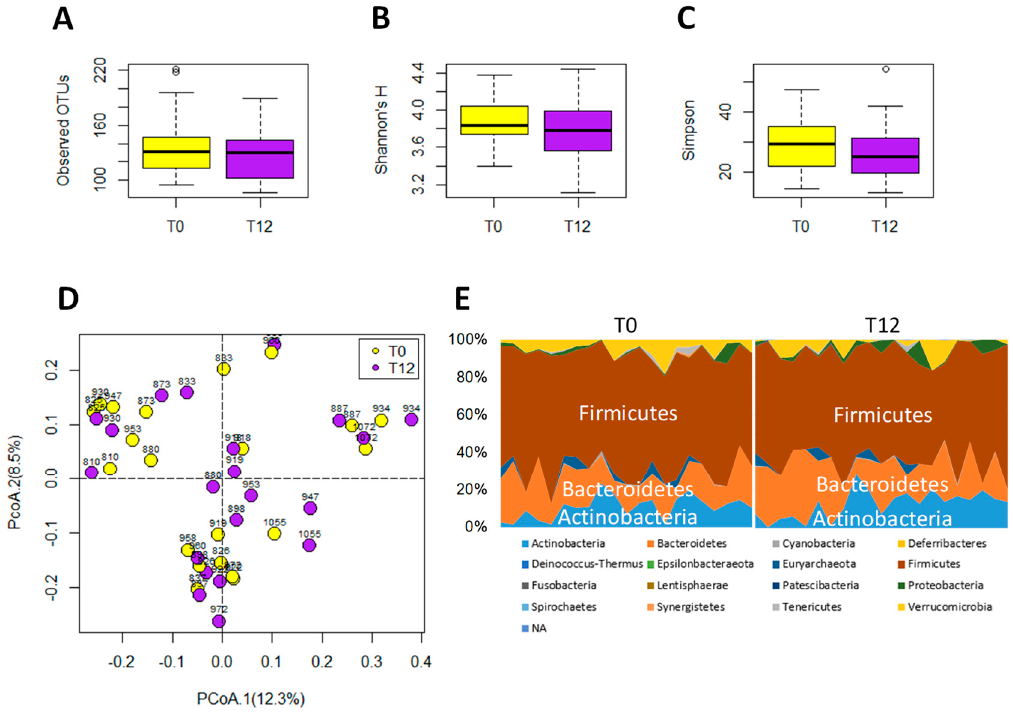
Figure 5. Microbiome analysis of paired T0 and T12 fecal samples. ( A ) Number of operational taxonomic units (OTU) detected by 16S rRNA gene analysis. ( B ) Shannon’s H index. ( C ) Simpson index. ( D ) Distribution of paired T0 and T12 samples with their ID numbers in a principal coordinates analysis (PCoA) model on fecal microbiome. ( E ) Relative abundances of individual phyla in T0 and T12 samples.